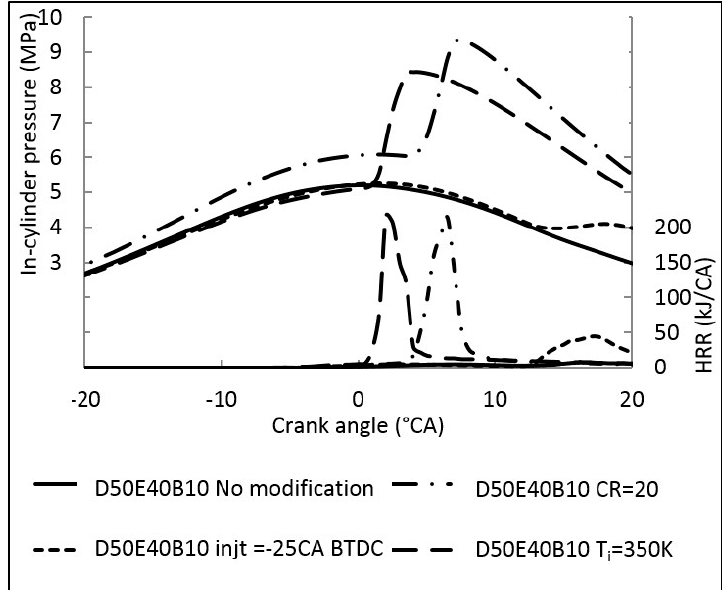
Figure 17. Pressure and HRR graphs of the D50E40B10 blend running at 1600 RPM at di ff erent modification